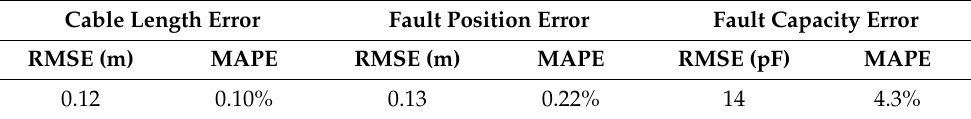
Table 8. Estimation errors obtained for experimental